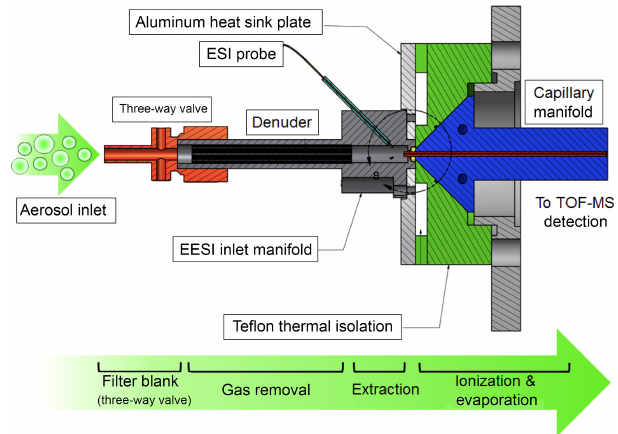
Figure 1. Schematic of the EESI-TOF inlet and ion source, includ- ing connection to